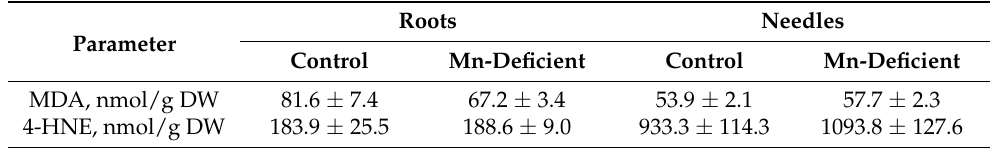
Table 4. Content of lipid peroxidation products in Scots pine at the 24th week of the experiment.